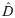
Model performance.The prediction performance of the latent space model, the latent eigenmodel and the two baseline approaches, quantified using the negative log-likelihood (NLL), the mean absolute error (MAE), the false-positive rate (FPR) and the false-negative rate (FNR). All measures are obtained using ten-fold cross-validation. Error bars indicate one standard deviation over the ten folds. In the top row, the number of dimensions D^ with the best generalization performance (i.e. the highest likelihood on hold-out data) is indicated with a vertical line. For the two macaque data sets, results are also shown for the fixed-positions model (see Section Link prediction). All scores have been normalized by the number of testing connections, for comparison between the different data sets.